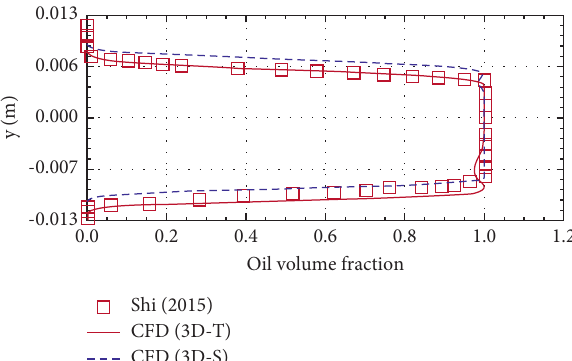
Figure 4: Comparison between the simulated oil volume fraction for mixture velocity 1.1m/s and the numerical results of The simulated axial mixture velocity of CAF for the two inlet configurations denoted 3D-T and 3D-S is shown in Figure 3. These mixture velocities are compared to the numerical results of Shi at the test line located at x � 0 and z � 100 and D � 2 . 6 m. The two velocity distri- butions give a small discrepancy with the Shi profile. The